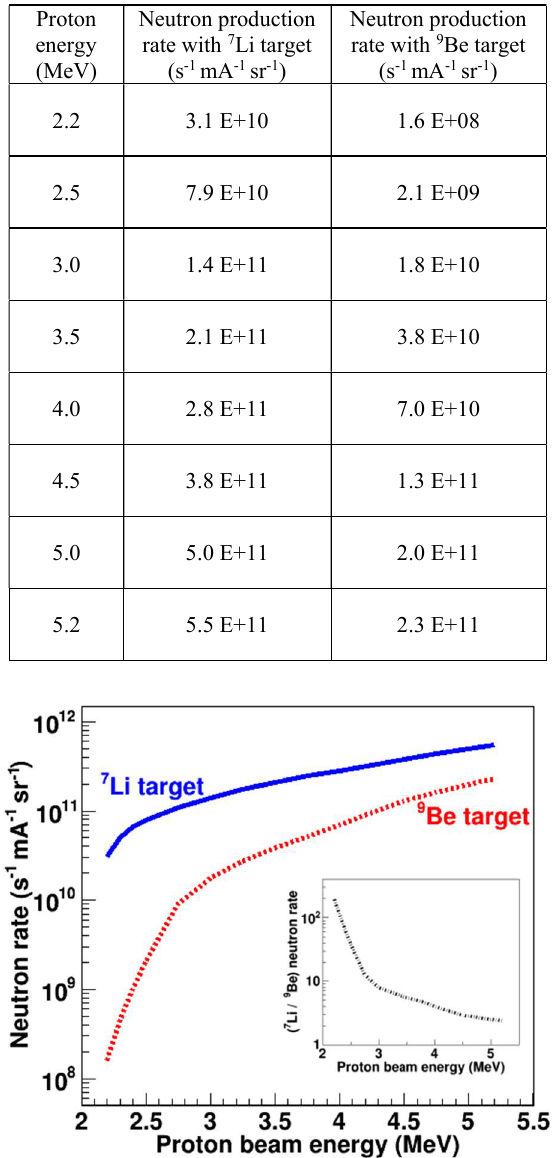
Table 2. Neutron rates for 7 Li and 9 Be thick target. The rates are calculated taking into account (p,n) cross sections from the ENDF/B-VIII.0 library [24]. For the 9 Be target, the neutron production due to breakup was also included, taking into account our recent measurements [13,19-20]. For a smaller energy step see Fig. 1.